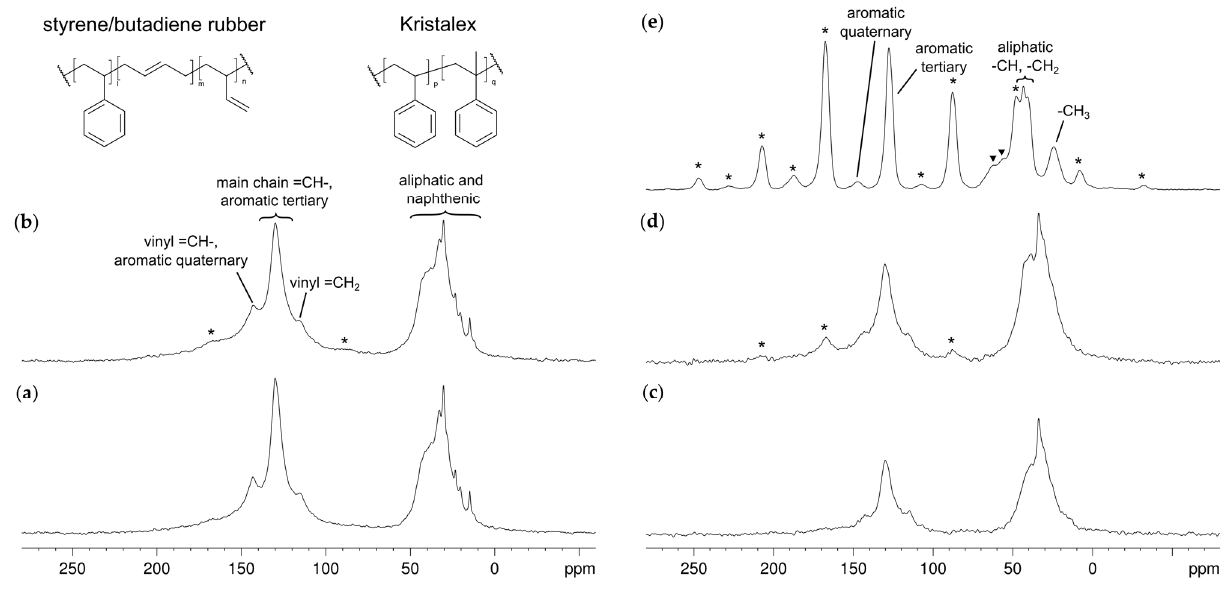
Figure 2. 13 C DE/MAS spectra of ( a ) vSBR and ( b ) vSBR_k recorded using a recycle delay of 20 s. 1 H- 13 C CP/MAS spectra of ( c ) vSBR, ( d ) vSBR_k and ( e ) Kristalex™ 5140 recorded using a contact time of 0.2 ms and a recycle delay of 4 s. Spinning sidebands are marked with an asterisk; impurities are marked with a filled triangle. All spectra were recorded using an MAS frequency of 5 kHz.